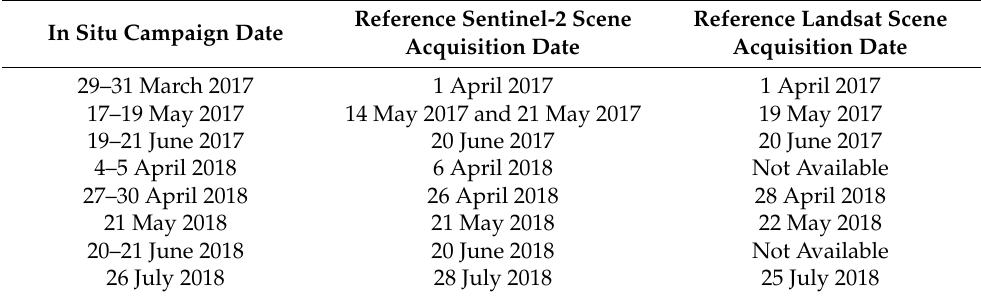
Table 2. Dates of in situ data collection campaigns and acquisitions of reference Sentinel-2 MSI and Landsat OLI